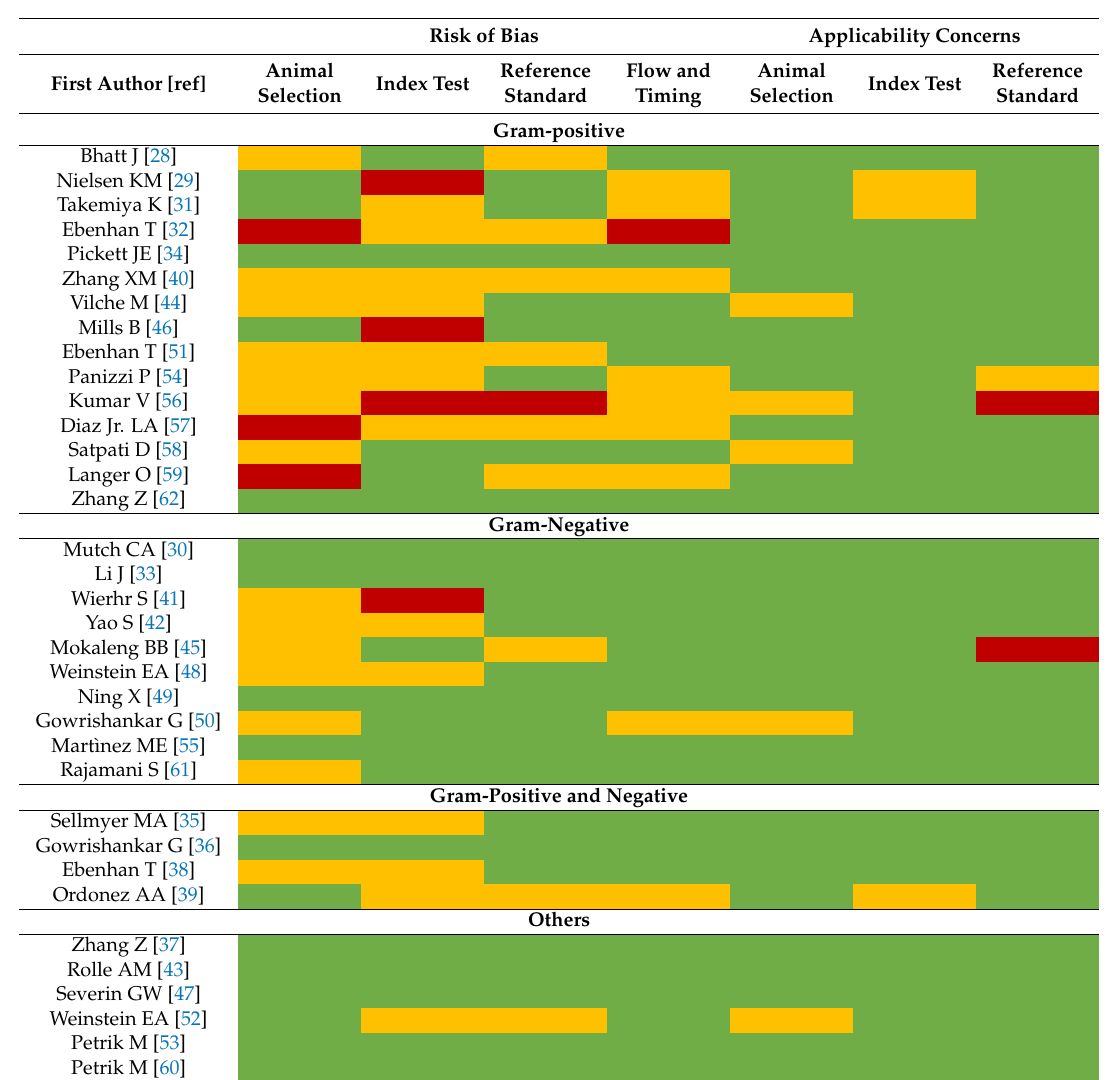
Table 2. Summary of QUADAS